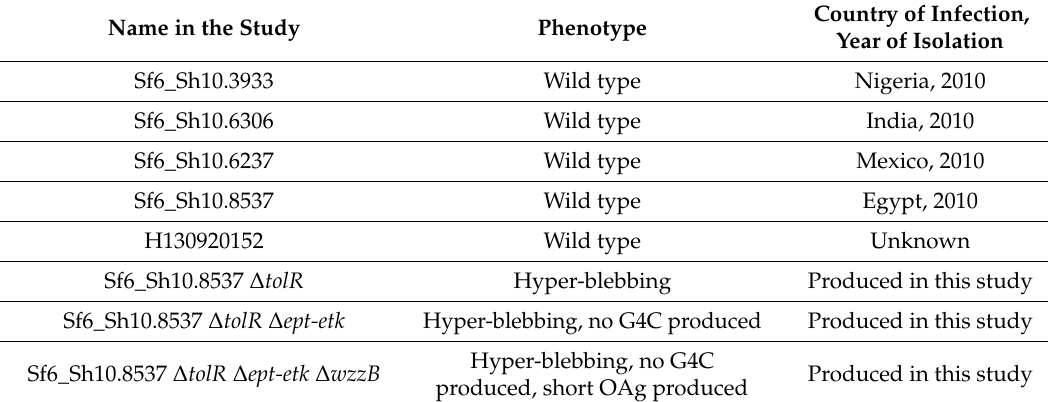
Table 1. Shigella flexneri 6 bacterial strains used in this study.